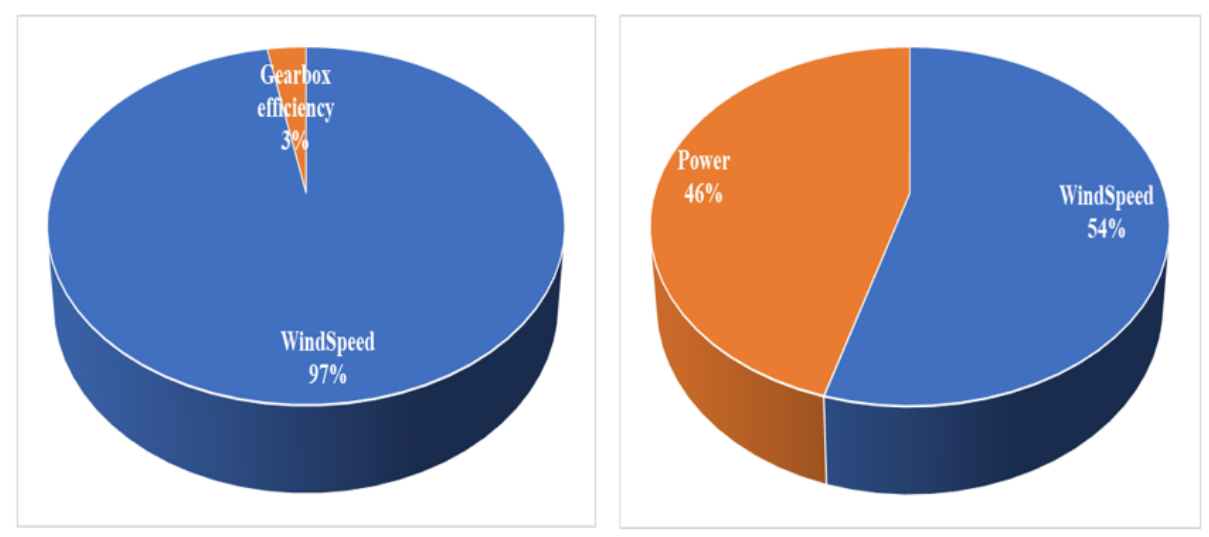
Figure 8. Importance analysis results for different input features; left figure: for power prediction, right figure: for gearbox efficiency prediction.